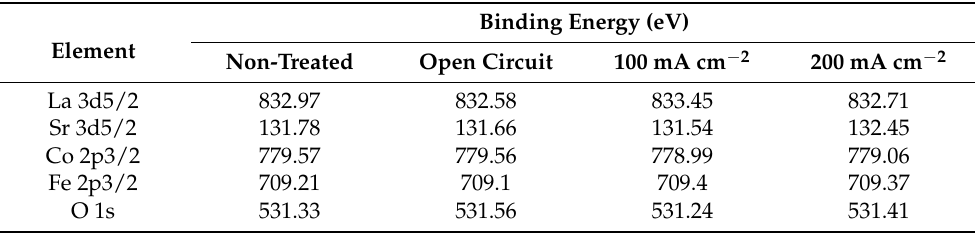
Table 2. Binding energy levels of LSCF cathode under different cathodic polarization currents as determined by